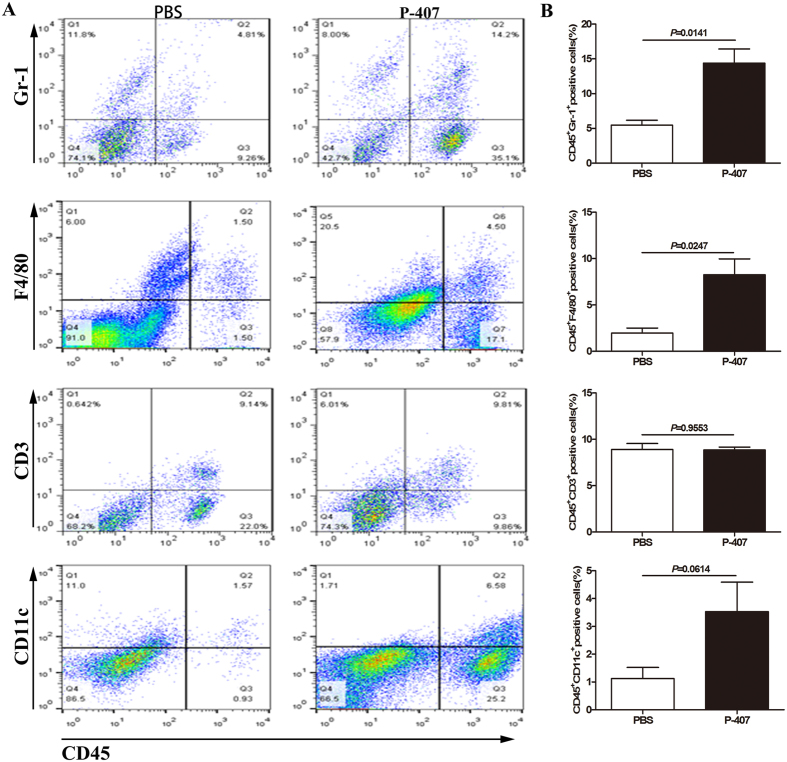
HTG promoted the infiltration of immune cells in pancreas in mice.HTG was induced by long term 28 days P-407 (0.5 g/kg) injection. n = 3–4 each group. (A) CD45+Gr-1+, CD45+F4/80+, CD45+CD3+, CD45+CD11c+ cells in the pancreatic tissues. (B) Numbers of the four types of cells of PBS group mice and P-407 group mice.